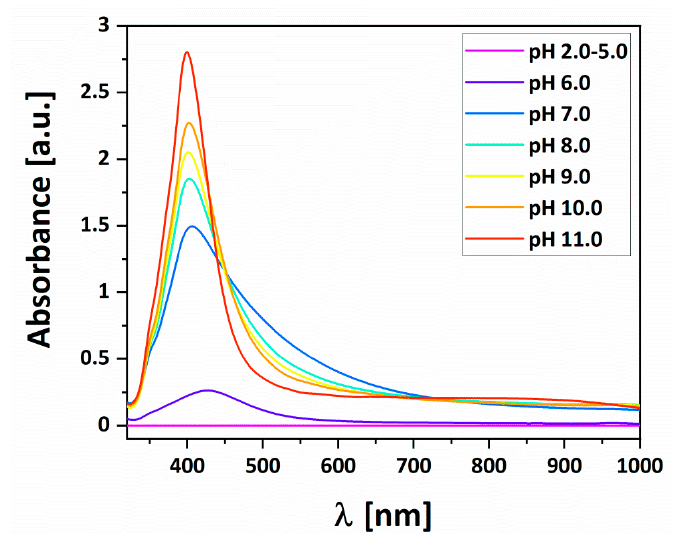
Figure 1. UV-Vis spectra of the silver nanoparticles reduced by citric acid at pH 2.0 to 11.0 in 1:1 dilution with deionized water.